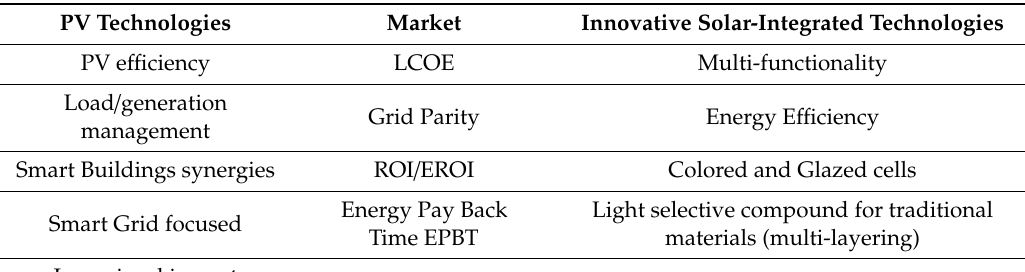
Table 3. Macro factors of BIPV on historical